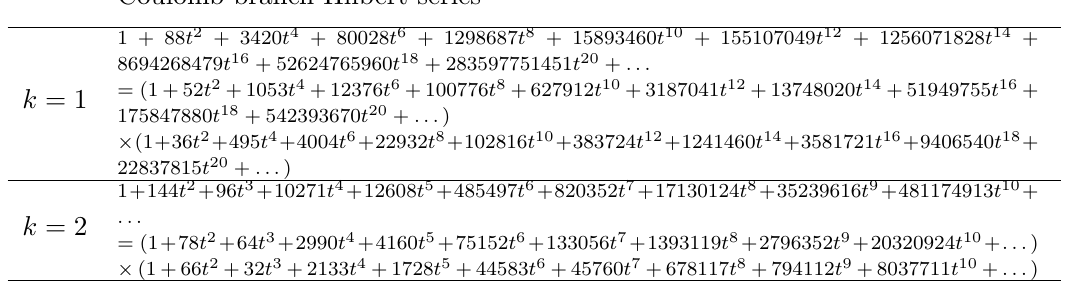
Table 19. Hilbert series results for (3.12). The first line displays the Coulomb branch Hilbert series for (3.12), while the second line displays the factorisation into a product. Each factor agrees with the known Hilbert